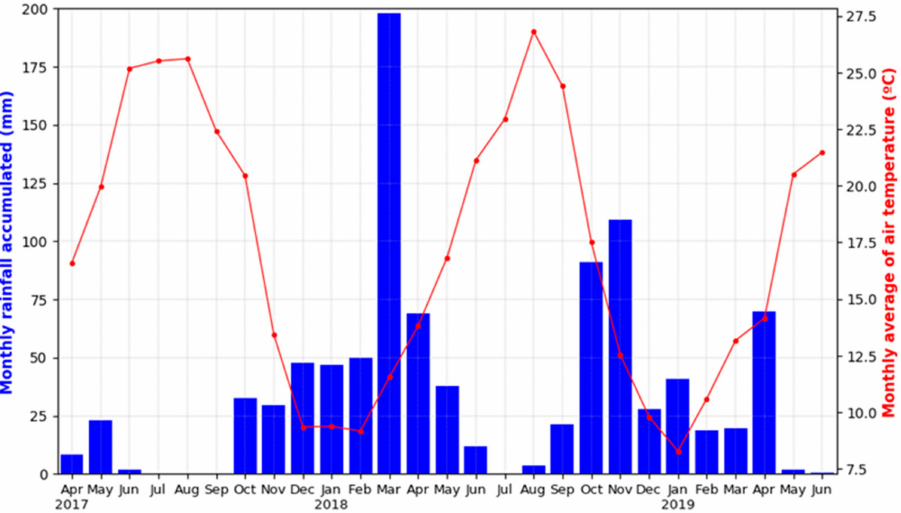
Figure 2. Monthly rainfall and air temperature in Alqueva for the period of April 2017–June 2019. Data from Cid Almeida meteorological